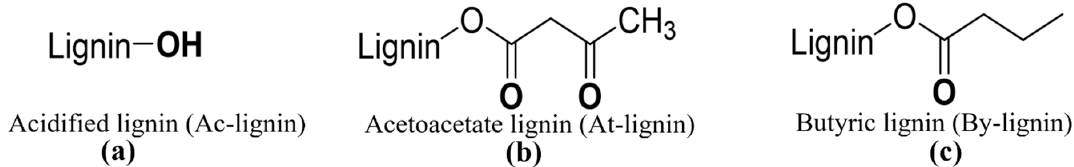
Table 1. Composition of PLA / Ac-lignin, PLA / At-lignin, and PLA / By-lignin